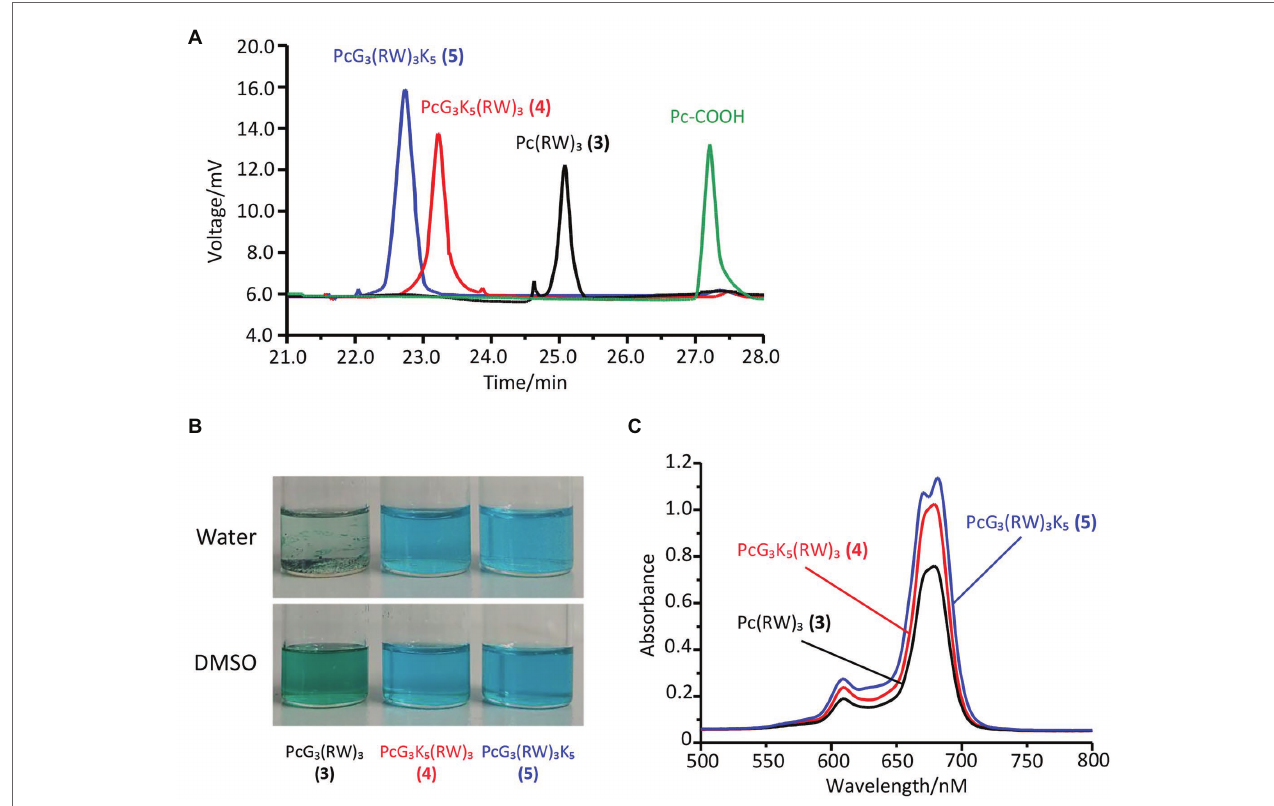
FIGURE 2 | Characterization of the antimicrobial Pc-peptides (APPs) and Pc-COOH. The APPs had high purity based on high-performance liquid chromatography (HPLC) profiles on C18 column (A) and different solubility in both dimethyl sulfoxide (DMSO) and water (B) . All APPs exhibited a strong absorption band at 678 nm in DMSO (C)